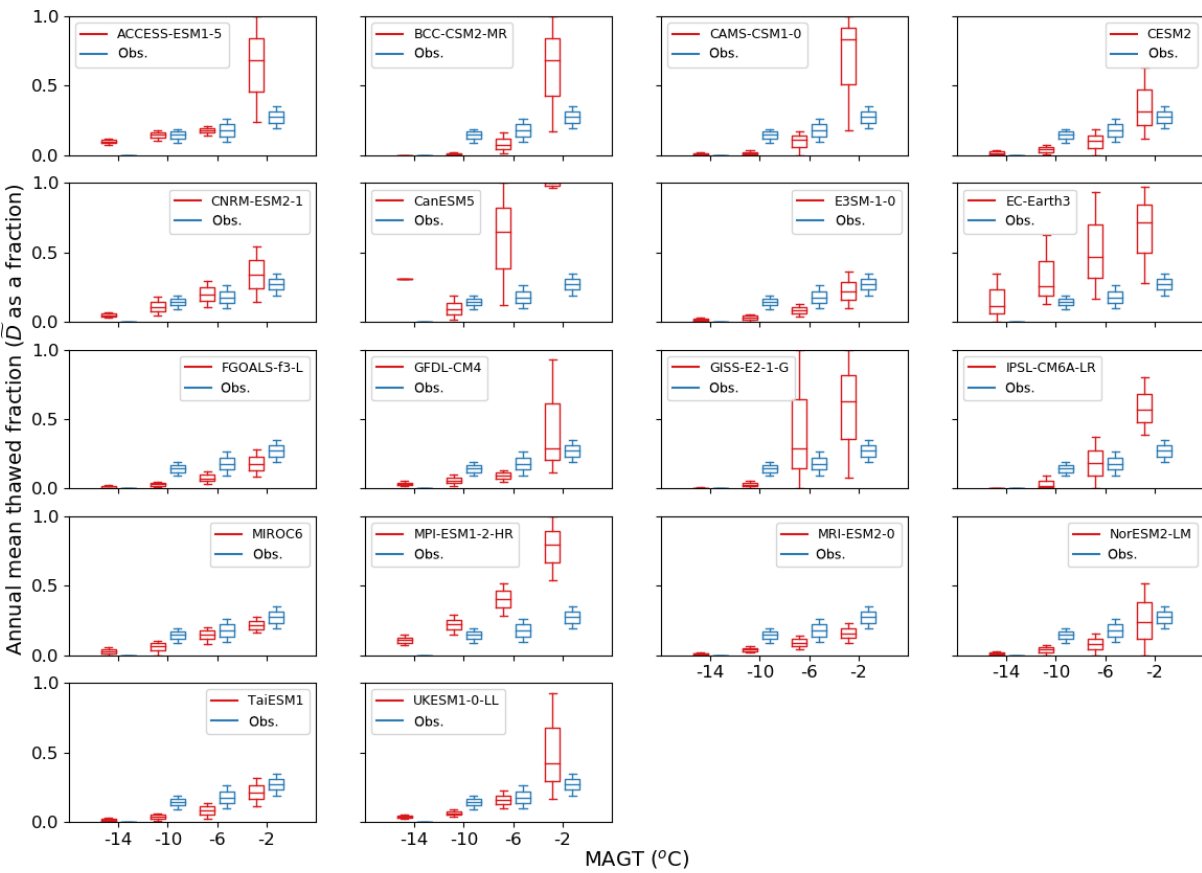
Figure 10. Relationship between the annual mean thawed fraction ( (cid:101) D ) and the MAGT from the site observations and the models in CMIP6 for the climatological period 1995–2014. Table 5. Projections of loss of PF benchmark , PF ex and (cid:101) D tot as a function of sensitivity to global surface air temperature change (GSAT). The 50th percentile is shown in bold.